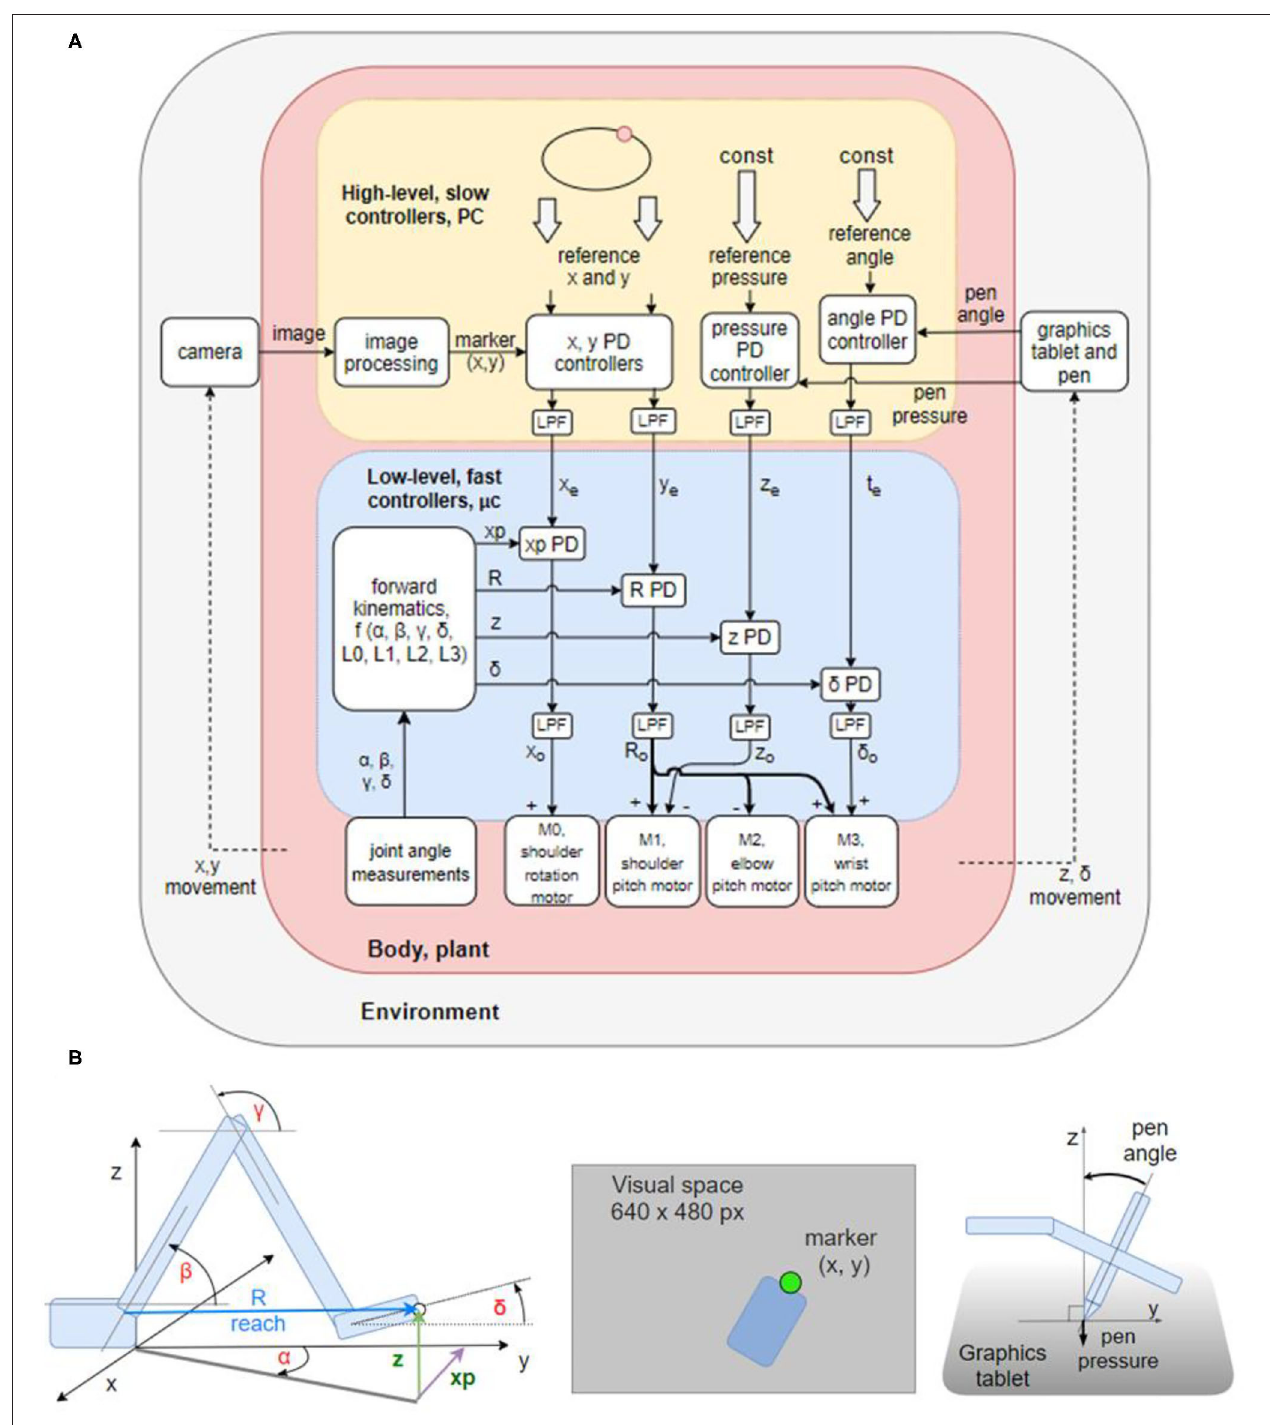
FIGURE 2 | Block diagram of the robot arm control systems and geometric definitions of the variables involved. (A) Block diagram of two levels of feedback loops, high level (yellow) and low level (blue). There are four high-level controlled variables: position of the marker in (1) x and (2) y dimensions in the visual field, (3) angle of the pen to the tablet, and (4) pressure of the pen to the tablet. The references for those variables are supplied by the experimenter at each run. The outputs from higher-level loops are references for the lower-level loops controlling four proprioceptive variables: (1) xp : the x coordinate of the hand tip in proprioceptive space; (2) reach, R: the distance from the shoulder base to the hand tip; (3) z: the height of the hand tip; and (4) delta ( δ ) : the angle between the x-y plane and the hand. All controllers are proportional-derivative (PD) with a low-pass filter (LPF) in controller output. (B) Diagrams showing the geometric definitions of variables in the block diagram, the visual space, and a diagram of the pen angle and pressure